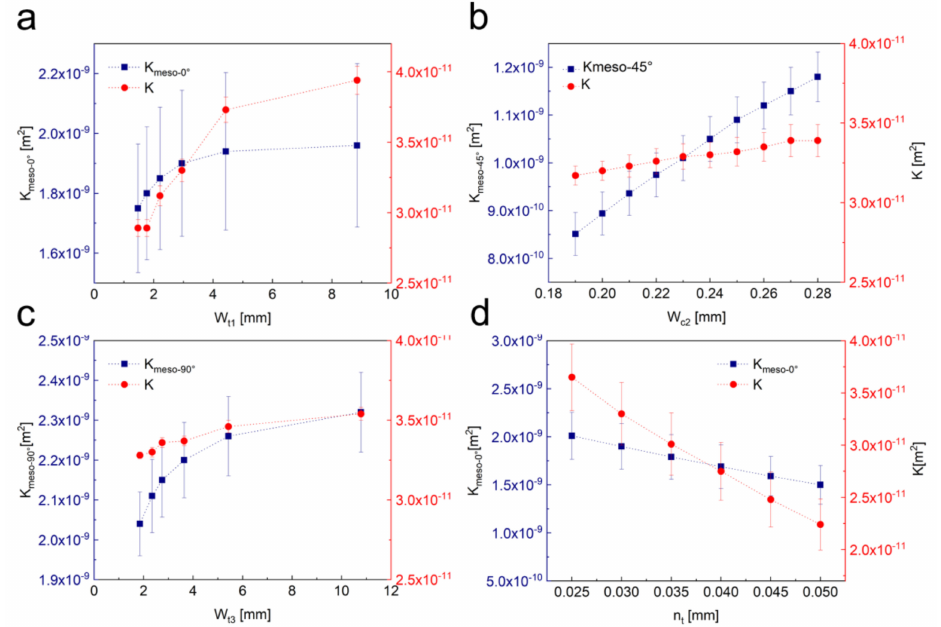
Figure 13. E ff ect of fabric structural parameters on in-plane permeability. ( a ) width of 0 ◦ tows; ( b ) width of 90 ◦ tows; ( c ) width of the wedge-shaped channel in ± 45 ◦ fiber piles; ( d ) maximum vertical displacement of ± 45 ◦ fiber piles in the nested